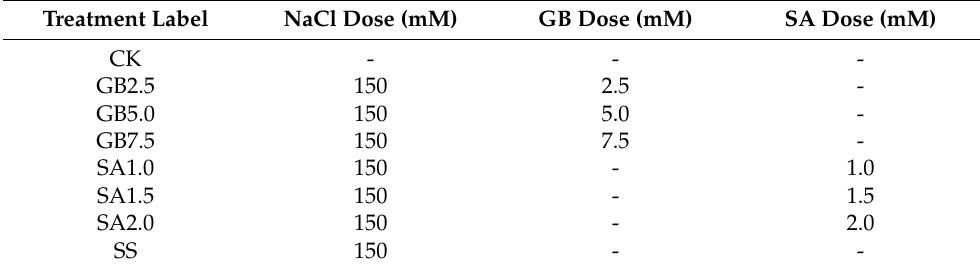
Table 4. The detailed experimental